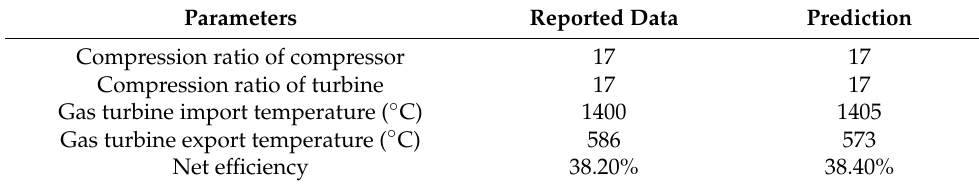
Table 6. Comparison of subunit forecasts with reported data of TURB.